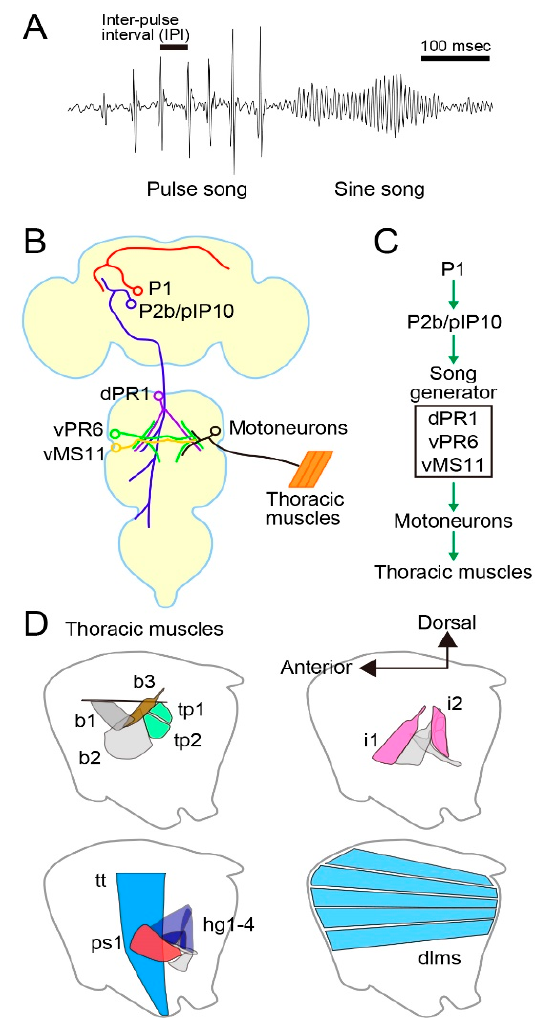
Figure 1. Neural and motor systems for courtship song generation in Drosophila melanogaster . ( A ) Song structure. ( B , C ) Neural components for song production ( B ) and their hierarchical organization ( C ). ( D ) Major muscles for song generation.